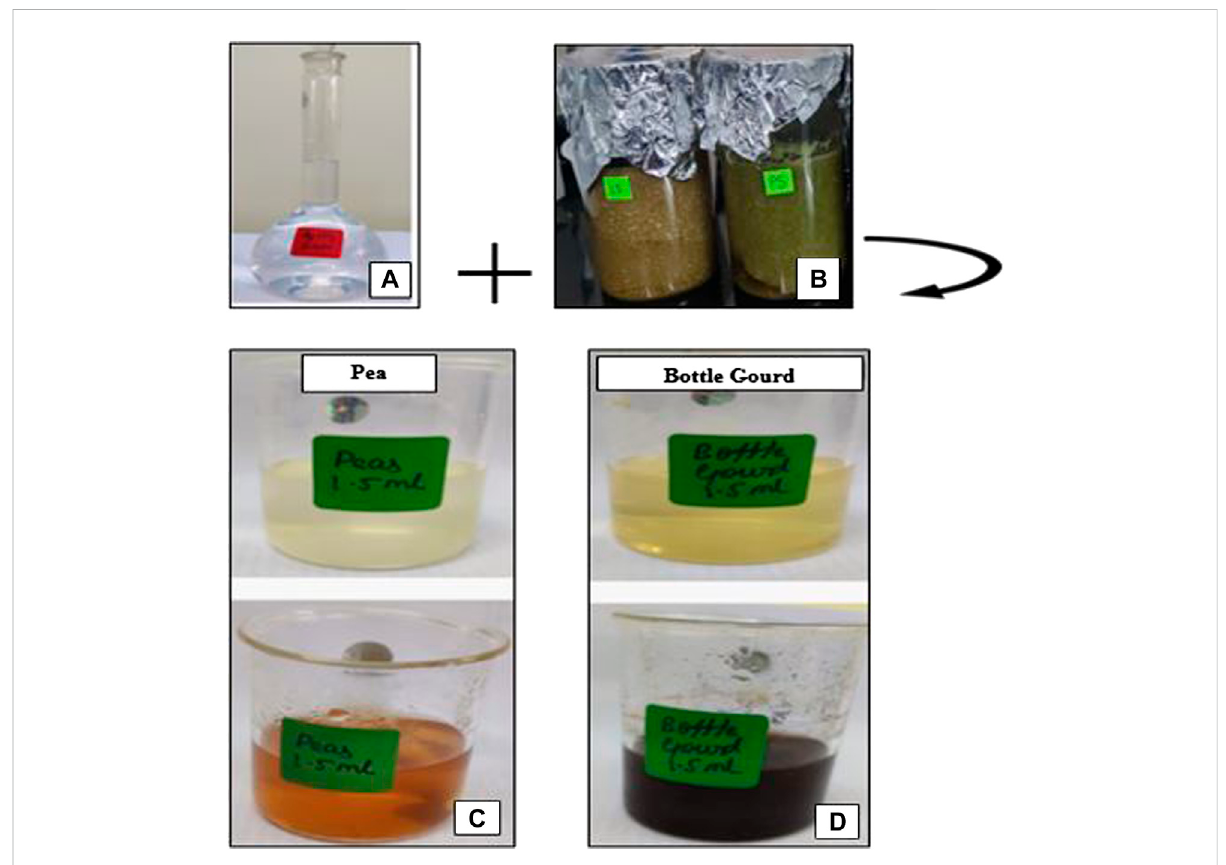
FIGURE 3 Formulationofsilvernanoparticleswithpea( Pisumsativum) (A) andbottlegourdpeels( Lagenariasiceraria) (B) extractedwith1 mMsilvernitrate solution. Color change observed before and after the incubation period during the synthesis of silver nanoparticles (C,D)